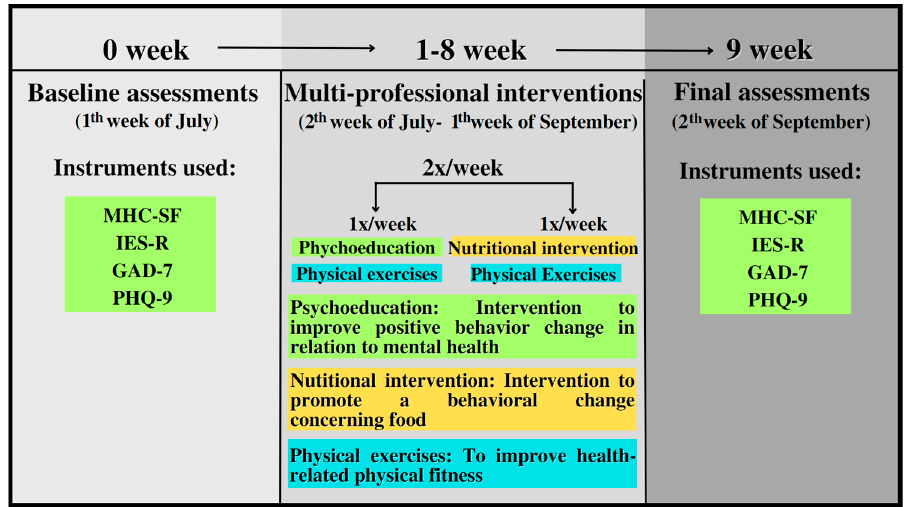
Figure 2. Summary of multi-professional interventions. MHC-SF = Mental Health Continuum–Short Form; IES-R = Impact of Event Scale—Revised; GAD-7 = Generalized Anxiety Disorder; PHQ-9 = Patient Health Questionnaire.